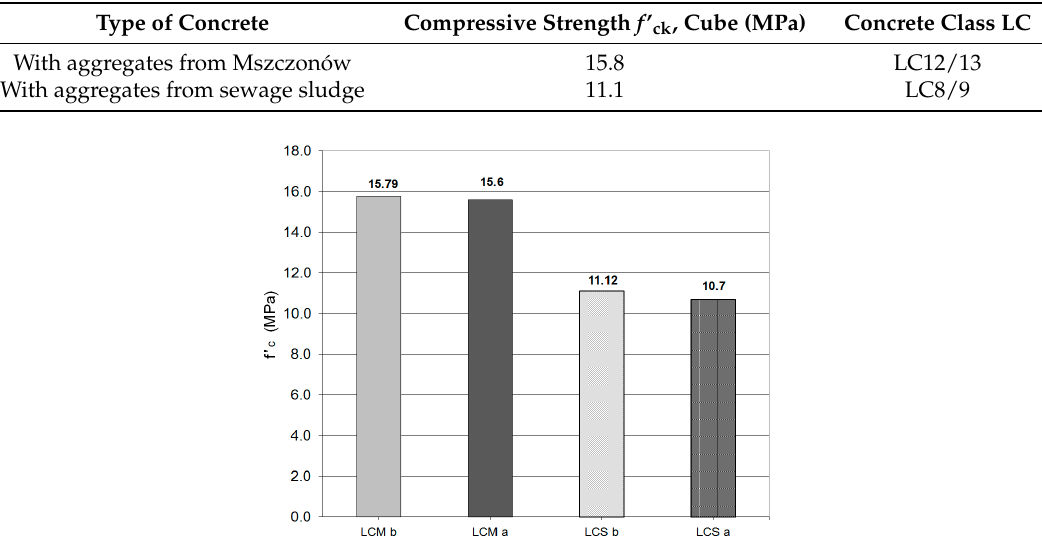
Table 7. List of compressive strengths of examined lightweight concrete samples.